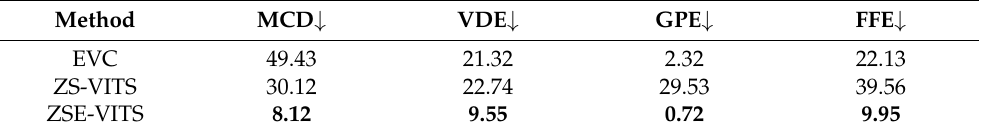
Figure 2. Spectrums of pitch (F0) and energy control. Table 4. Objective prosody evaluation (The down arrow indicates that the lower the metric value, the better the